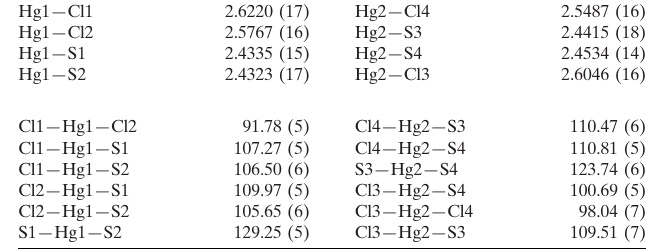
Selected geometric parameters (A˚ , (cid:3) ).